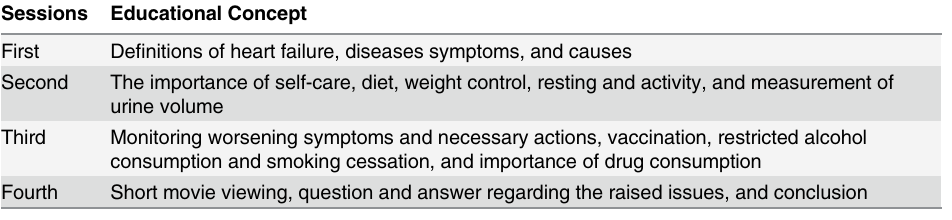
Table 1. Structure and Concept of Educational Sessions for the Patients with Heart Failure. Sessions Educational